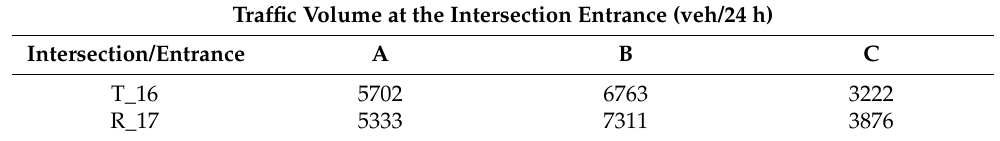
Table 4. Daily traffic volume (MDTD) at the entrances to the intersection detected during the working day at the three-arm intersection (T_16) and roundabout (R_17) in Žilina City.